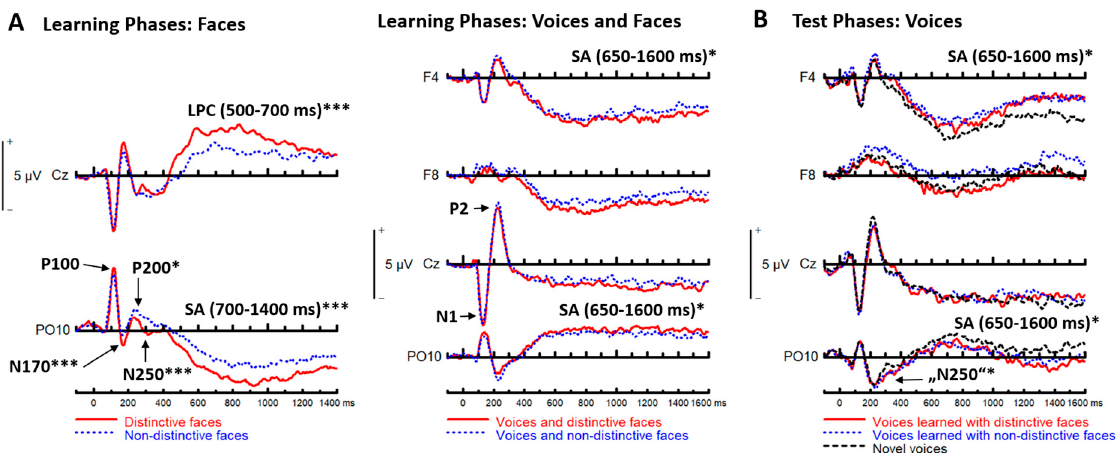
Figure 3. Grand mean averages of uni − modal face-elicited ERPs at Cz and PO10 for both learning conditions in the learning phases ( A , left ), voice − elicited ERPs at F4, F8, Cz and PO10 for voices presented with distinctive or non − distinctive faces ( A , right ), unimodal voice − elicited ERPs at F4, F8, Cz and PO10 in the test phases, for voices that had been originally learned with distinctive or non-distinctive faces, and for novel voices ( B ) (* p < 0.05, *** p < 0.001).